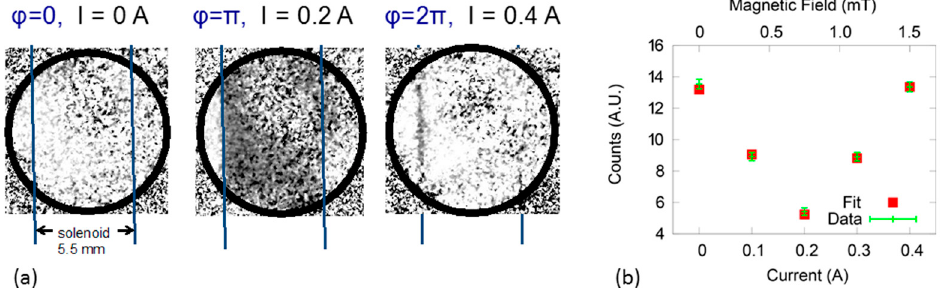
Figure 4. ( a ) Transmission images of the solenoid at three different applied currents. The reduction of transmission due to neutron spin rotation by the solenoid’s field is apparent. In the three images, the black circle is the boundary of the field of view and the parallel lines show the position of the solenoid. Due to the low number of counts, there is enhanced “salt and pepper” noise. ( b ) Average grey level value within the solenoid for given applied current and the fit using the cosine function. The uncertainty is the one-sigma root mean square deviation over the solenoid region.